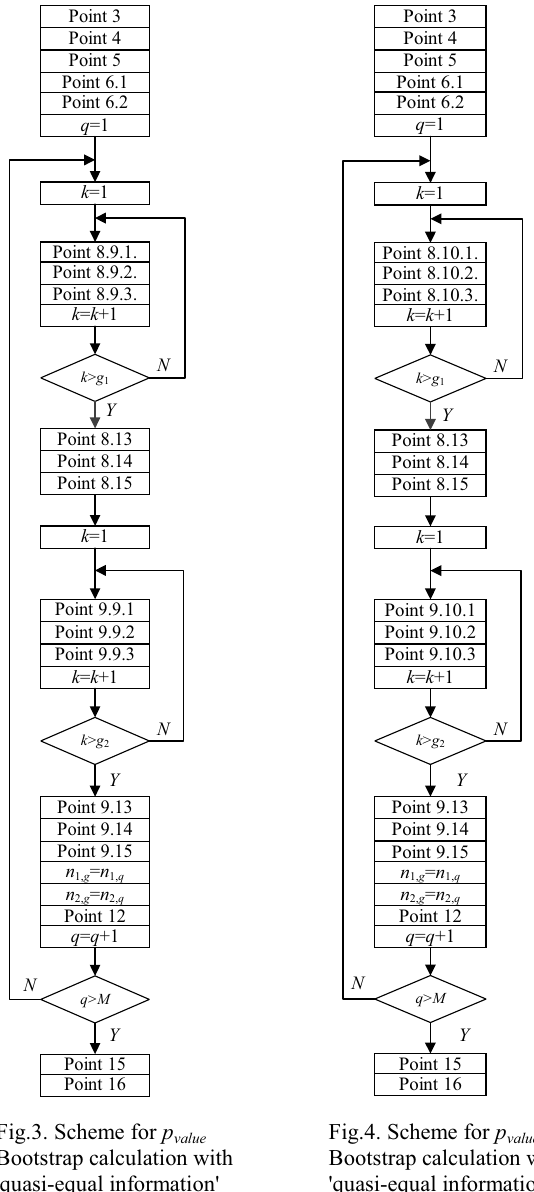
Fig.3. Scheme for p value Bootstrap calculation with